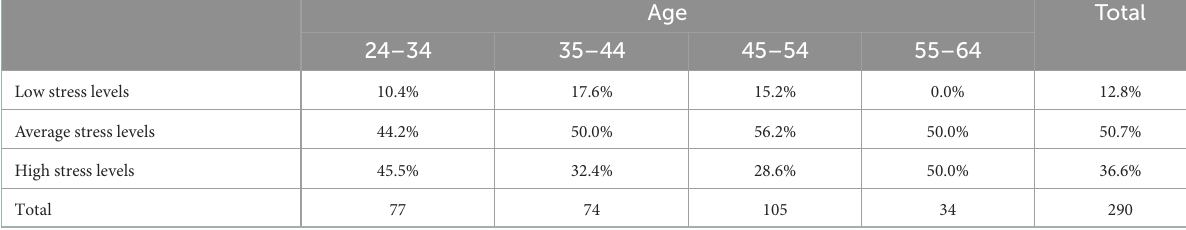
TABLE 2 Stress level with respect to age.